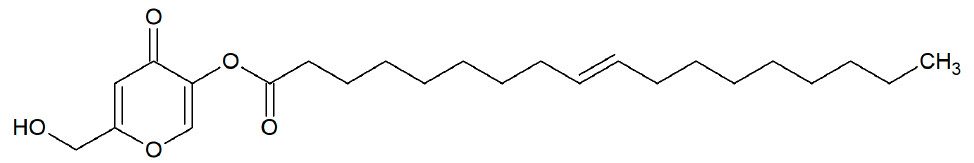
Figure 11. Chemical structure of kojic monooleate (KMO).